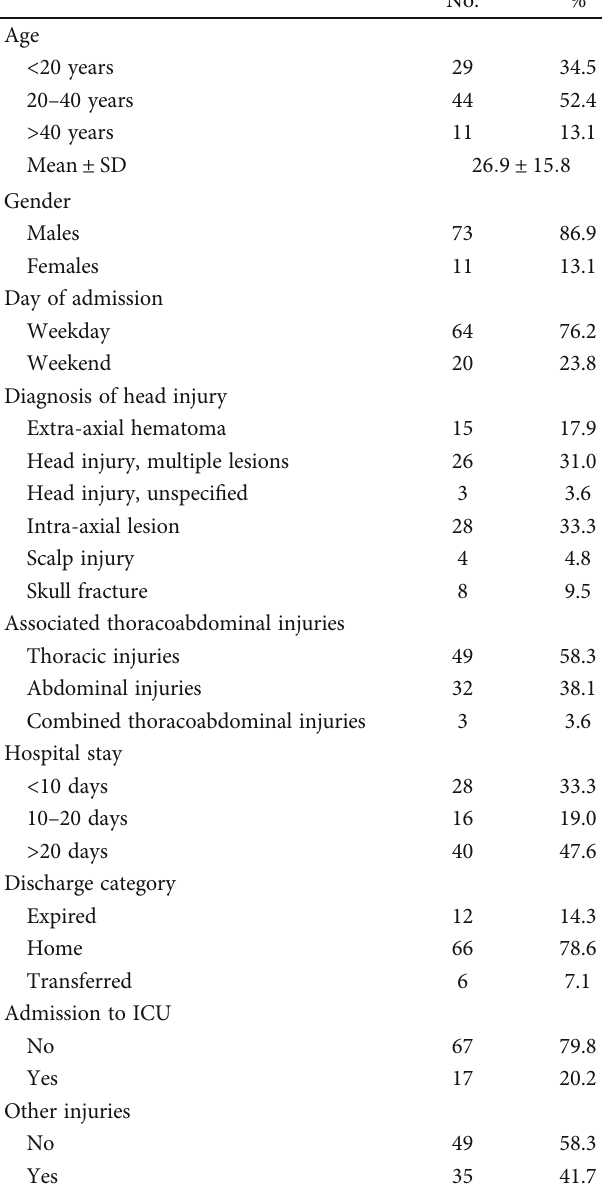
Table 1: Demographics and outcome of motor vehicle accident- related traumatic head injuries associated with thoracoabdominal injuries ( n = 84 ).